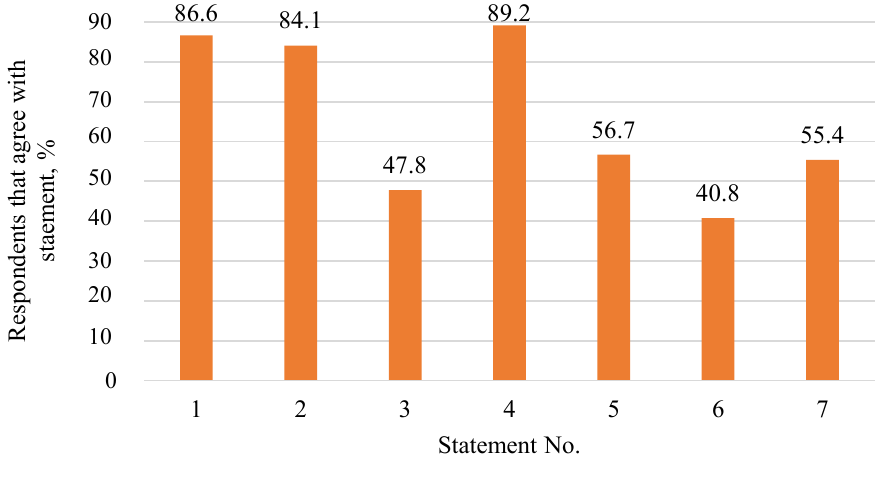
Fig. 2. Respondents that agree with statements in group “Knowledge on air